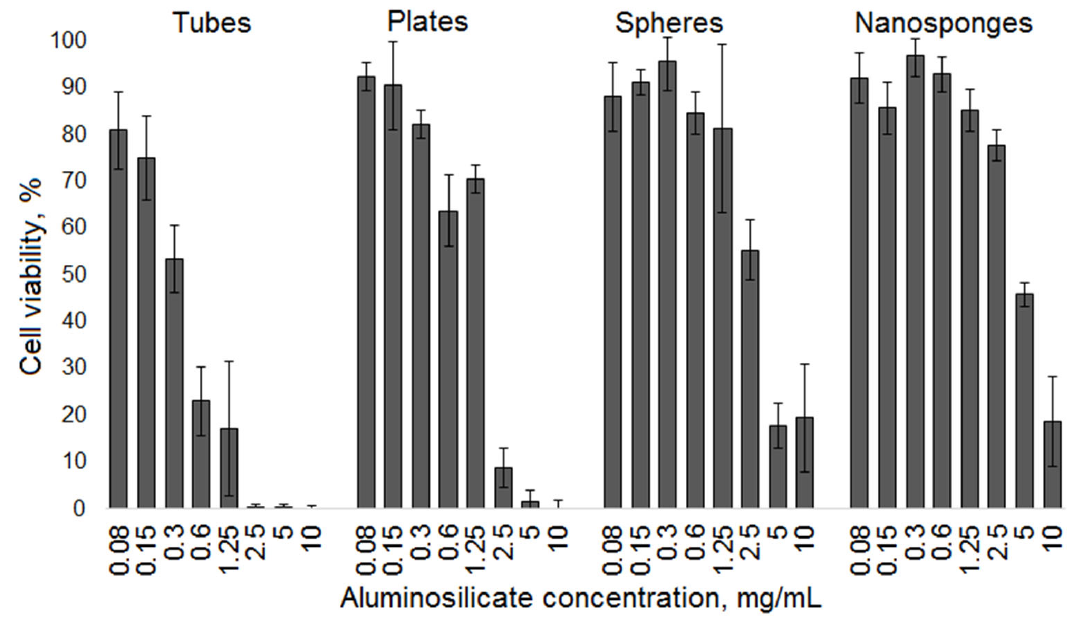
Figure 11. The effect of samples morphology on cell viability according to MTT test results.